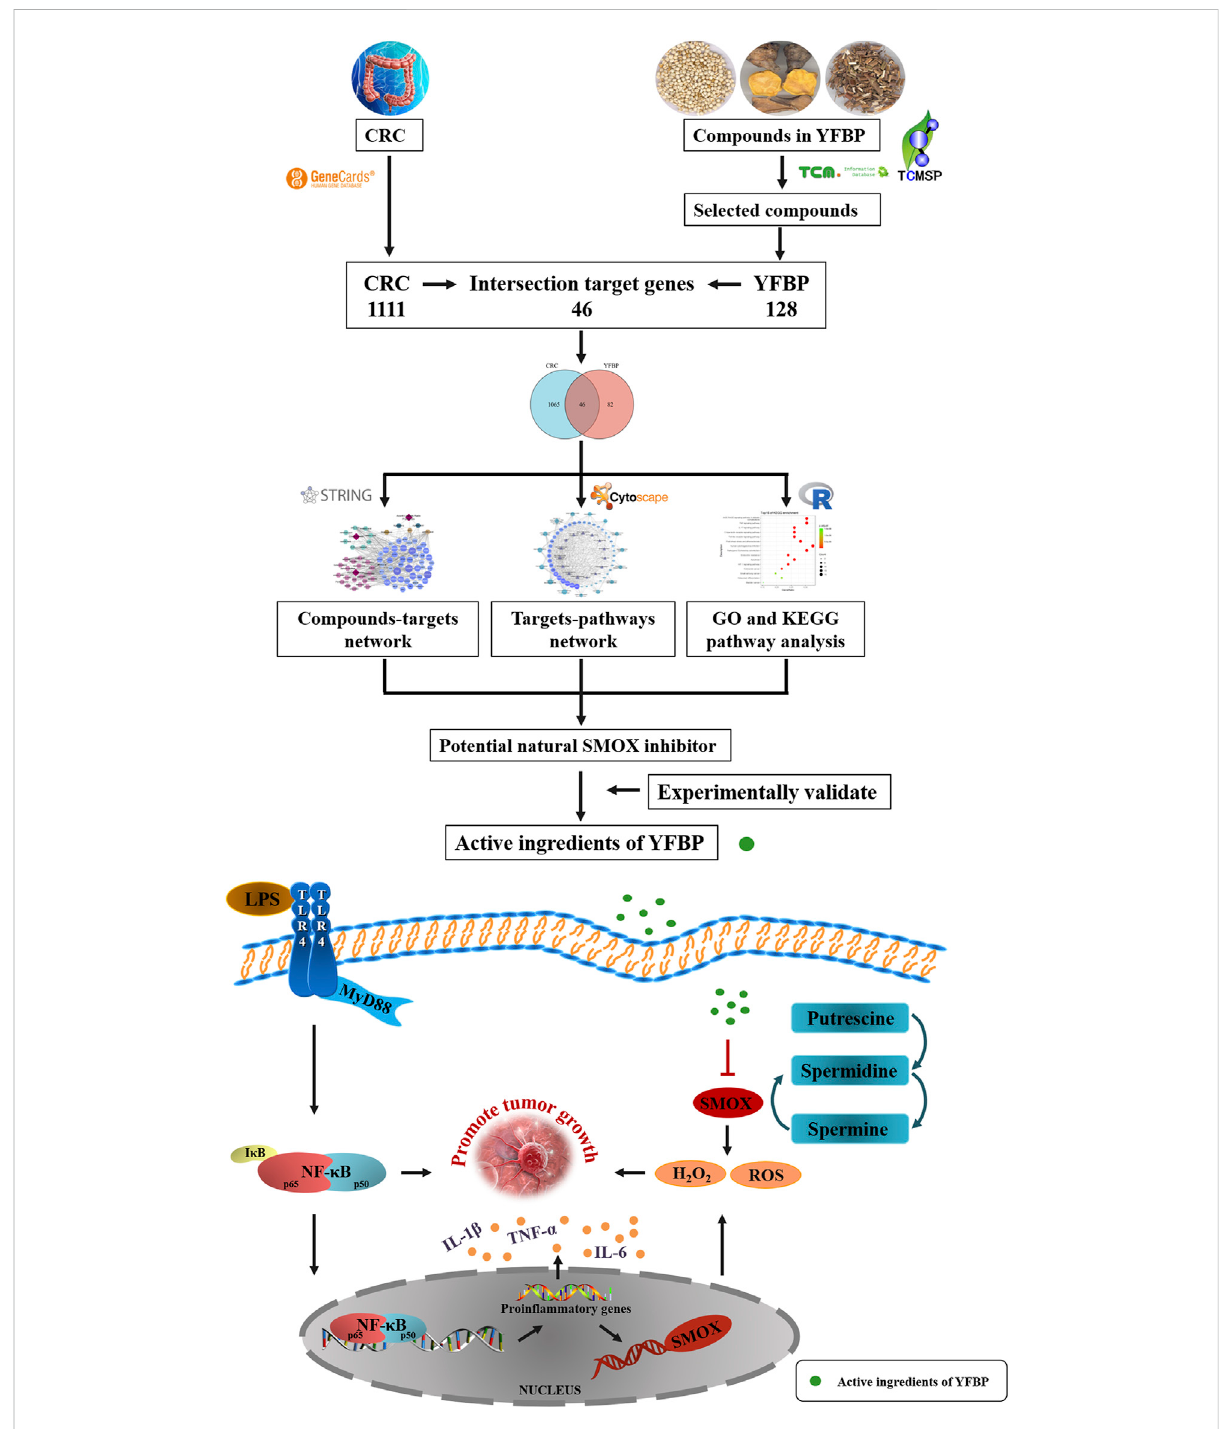
FIGURE 1 Working fl ow chart of SMOX inhibitor prediction in